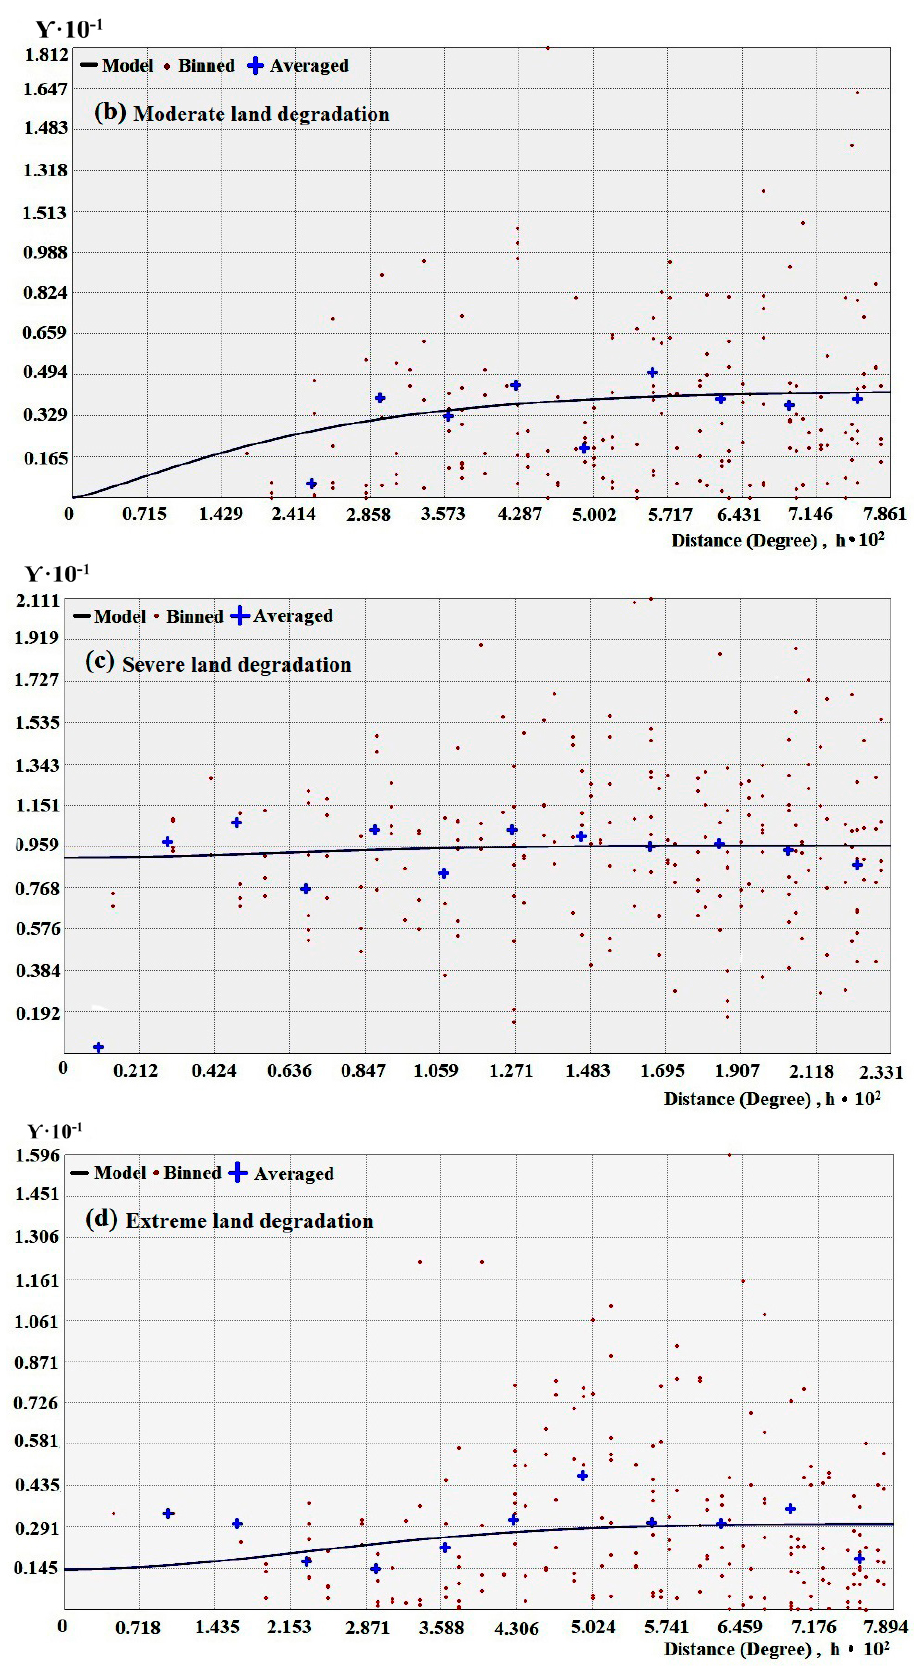
Figure 2. Experimental semi-variograms and fitted models for SOM different land degradation